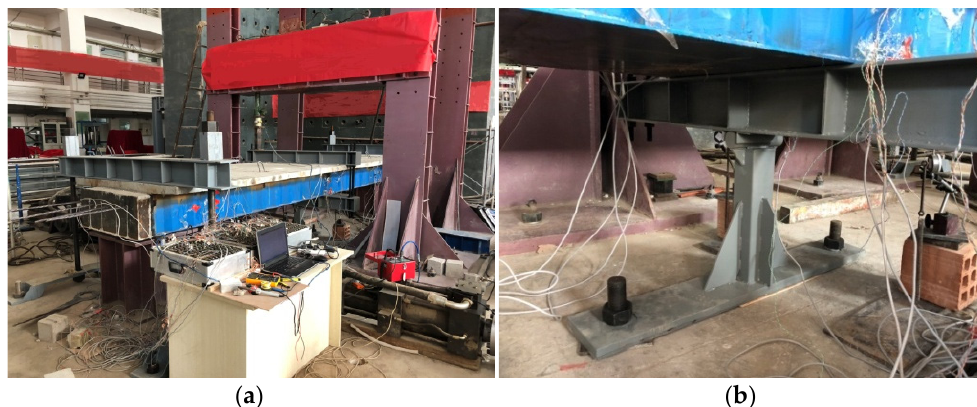
Figure 8. Test-loading photos: ( a ) load application; ( b ) revolute joint.